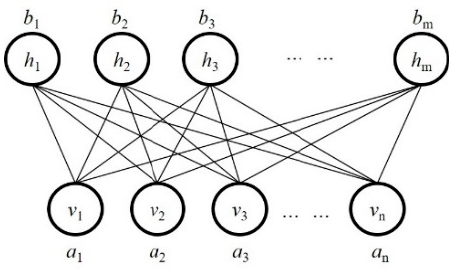
Figure 2. Network graph of an restricted Boltzmann machine (RBM) with n visible units and m hidden units.